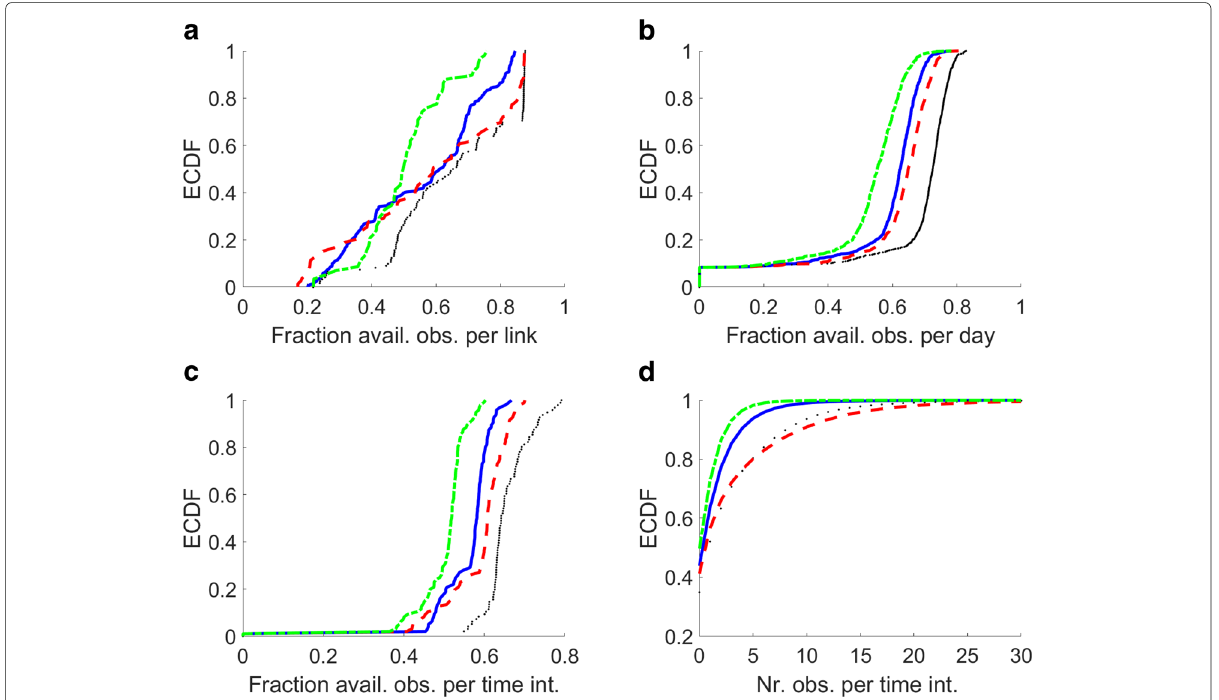
Fig. 2 Empirical cumulative distribution functions (ECDF) for data availability for a links, b days, c time-of-day-intervals given as relative frequency of observations. d provides ECDFs for the number of taxi observations per link per day per interval. Hietzing (blue), Westbahnhof (black, dotted), Ring (red, dashed), Südosttangente (green,